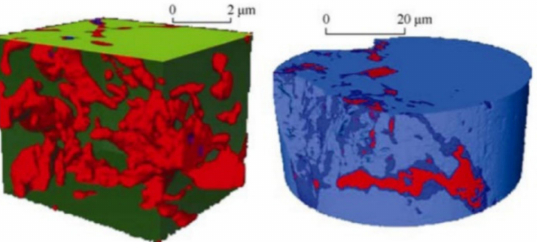
Figure 16. Micro-CT images of pore-throat interconnectivity in the Yanchang sandstone reservoir